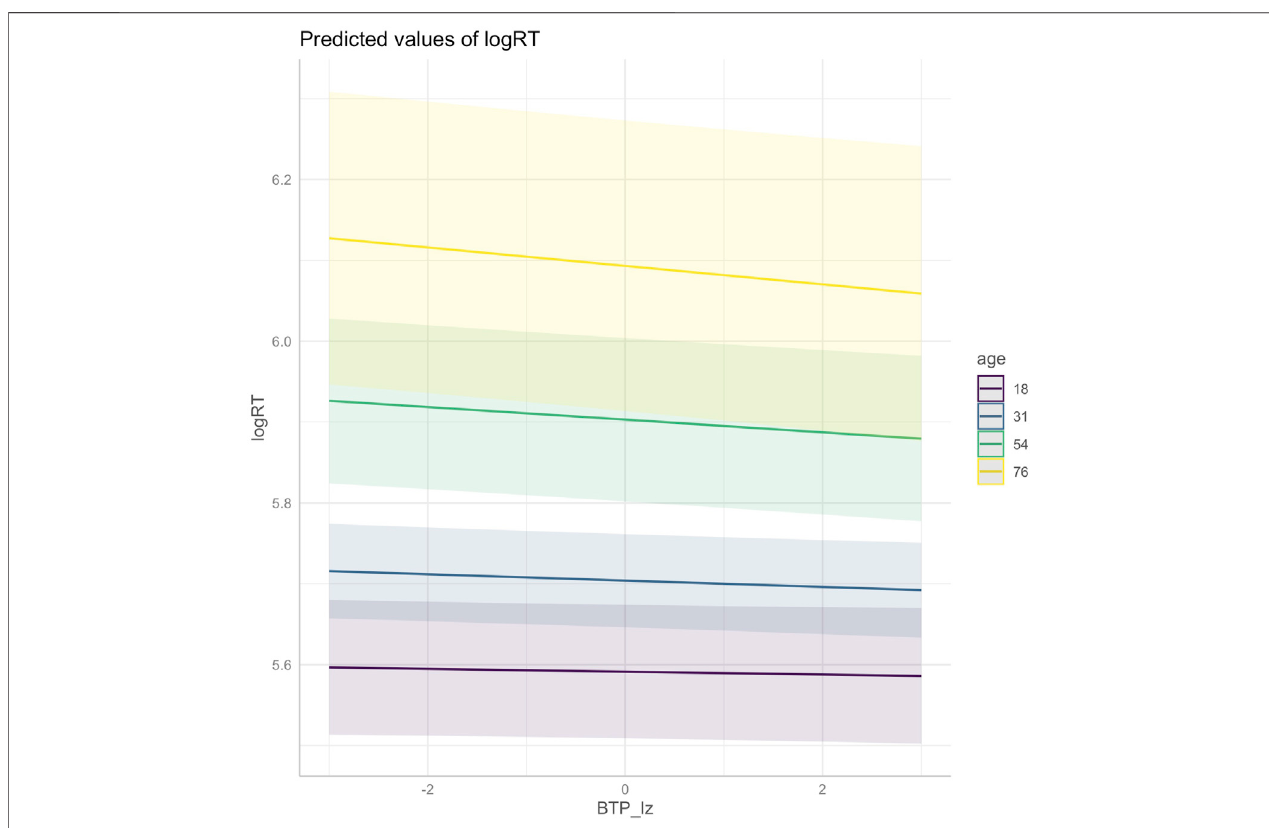
FIGURE 12 | Interaction between (log-transformed, z-scored) backward transition probability and age at sample ages (min: 18, median: 31, max: 76, and midway between median and max: 54).